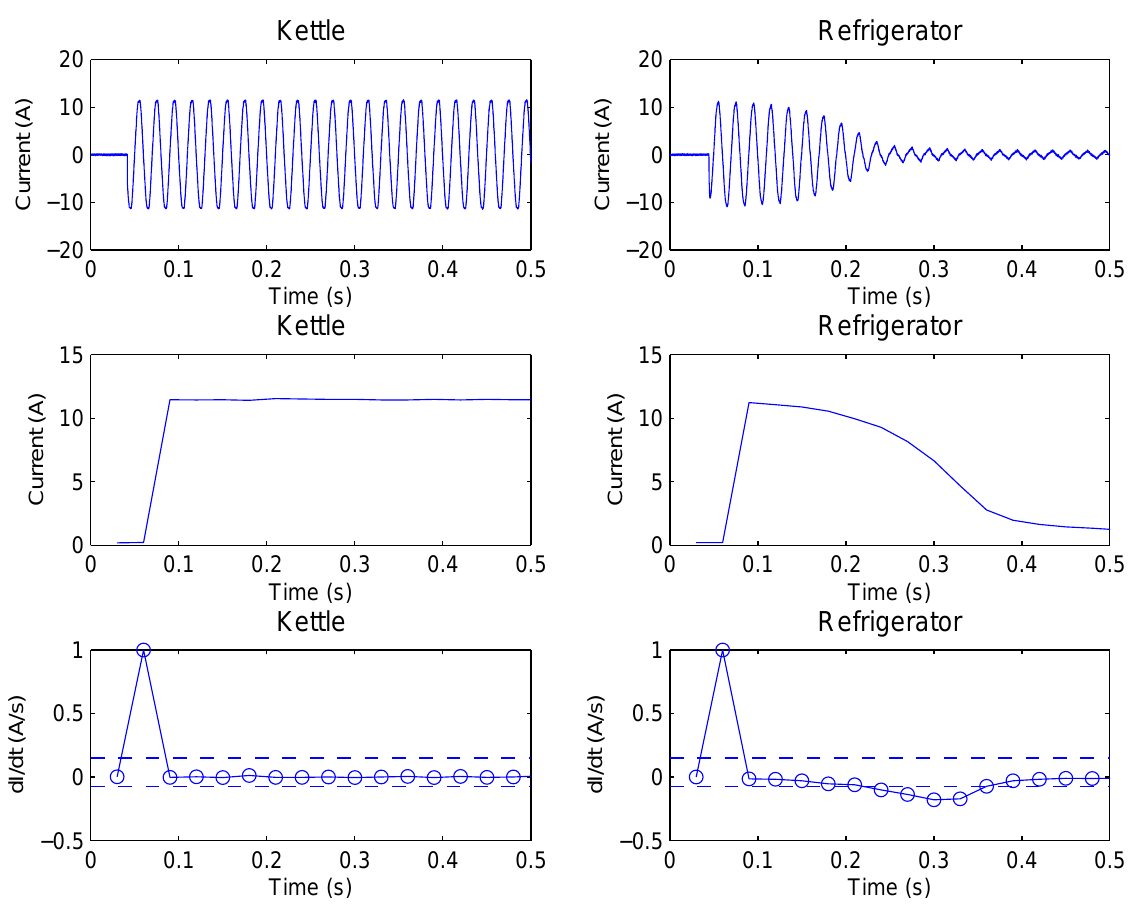
Figure 6. An example of a Type I and II transient signal, where the signal, profile and derivative of the envelope can be